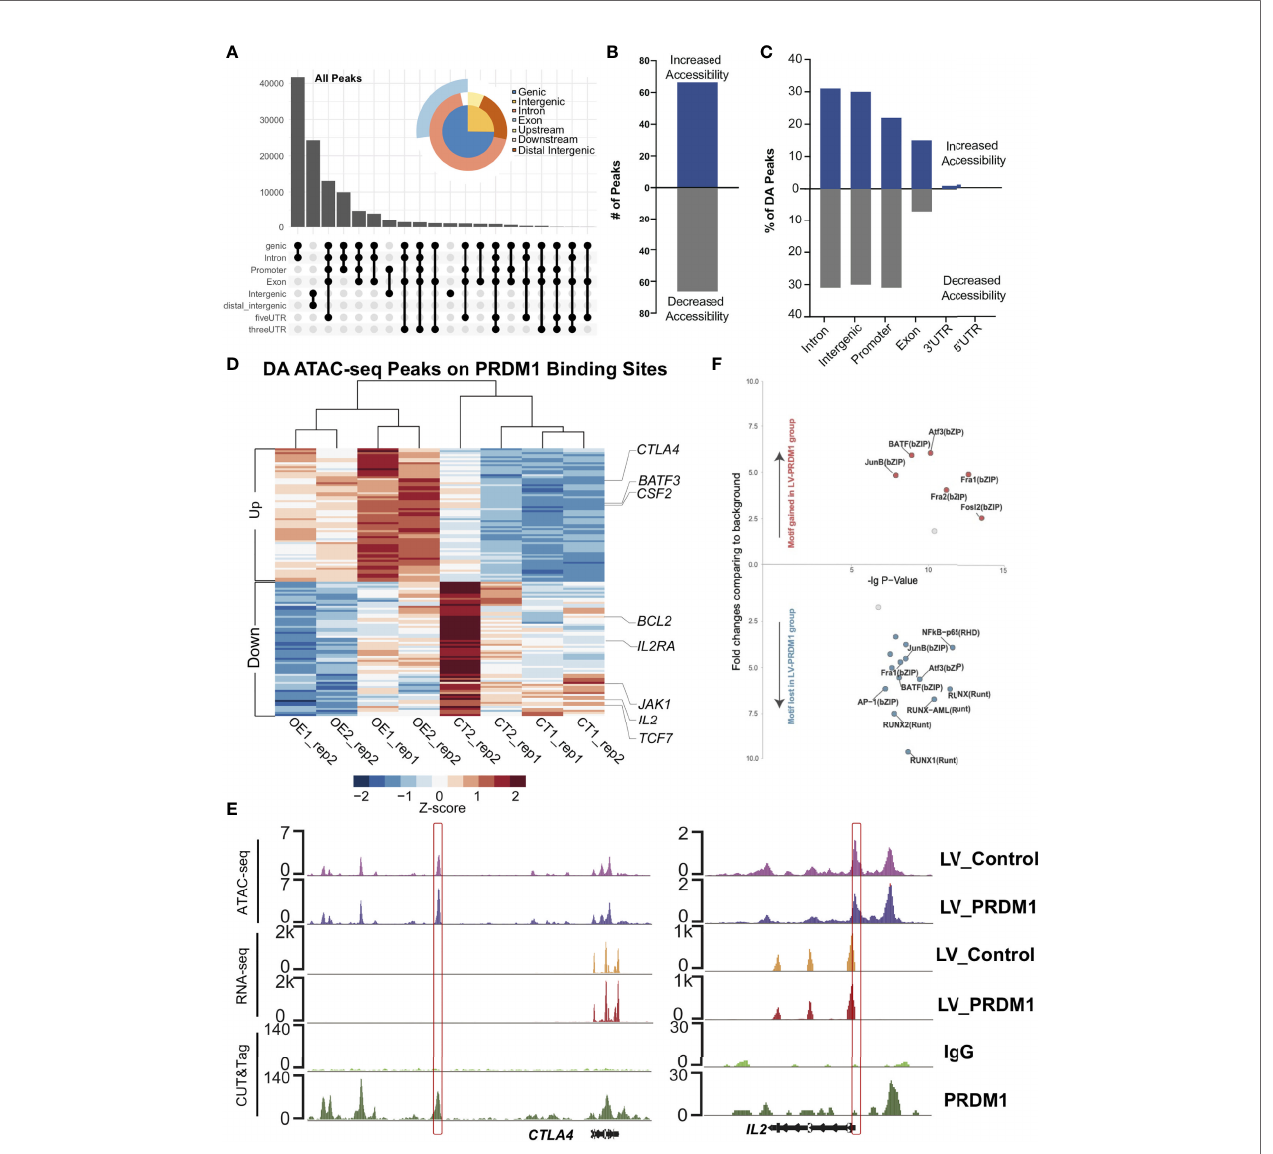
FIGURE 4 | PRDM1 reshaped the epigenetic pro fi le of T cell tolerance regulation-related target regions. (A) Categories of cis -element in all open chromatin regions (OCRs). (B) Overall OCR peak changes for PRDM1 -overexpressing T cells compared to control T cells. (C) Categories of cis -element OCR peaks that changed between PRDM1 -overexpressing T cells and control T cells. (D) Heatmap shown differentially accessible (DA) peaks overlapped with the PRDM1 CUT&Tag binding peaks between PRDM1 -overexpressing T cells and control T cells. Selected genes assigned to the peaks are indicated. FDR q-value < 0.05. (E) WashU browser views showed PRDM1 biding sites (CUT&Tag), related gene expression level (RNA-seq) and chromatin accessibility (ATAC-seq). (F) Transcription factor motif gain or loss associated with overexpression of PRDM1. X axis represents the -logP value of the motif enrichment. Y axis represents the fold change of the motif enrichment. Targeted motifs in the changed OCR between the LV-PRDM1 and LV-Control groups were compared to the whole genome background to calculate p value and fold